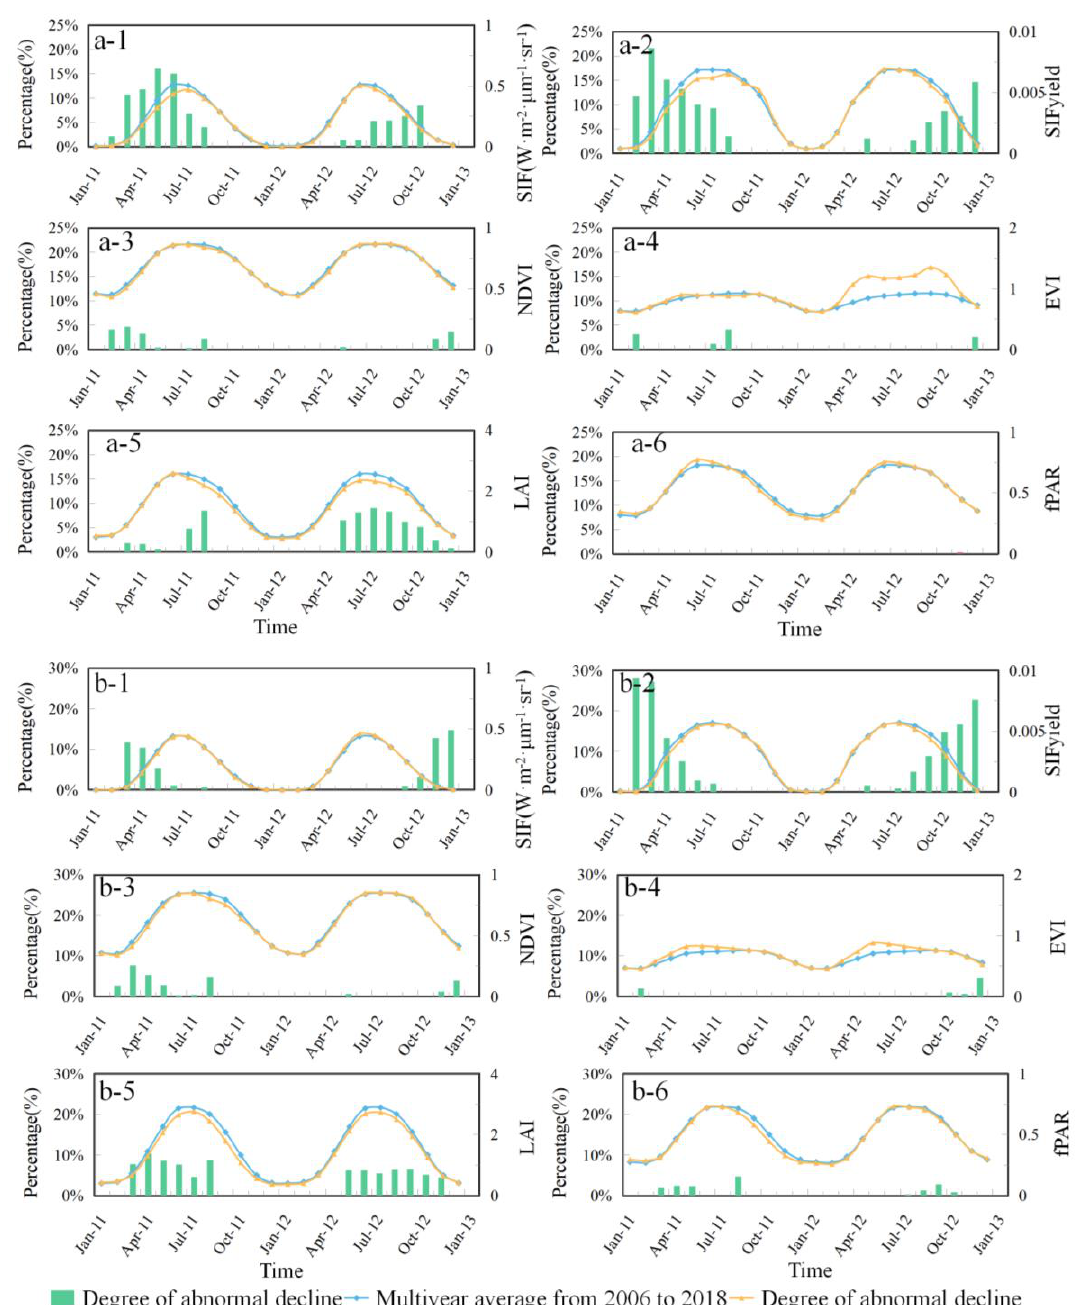
Figure A2. ( a1 – a6 ) The seasonal cycle variation curves of present values and multi-year averages and the abnormal decrease amplitude of the present values from the average values of SIF, SIFyield, NDVI, EVI, LAI, and fPAR, respectively, of the subtropical evergreen broad-leaved forest region in Shaanxi province ( b1 – b6 ). The seasonal cycle variation curves of present values and multi-year averages and the abnormal decrease amplitude of the present values from the average values of SIF, SIFyield, NDVI, EVI, LAI, and fPAR, respectively, of the warm-temperate deciduous broad-leaved forest region in Shaanxi province.